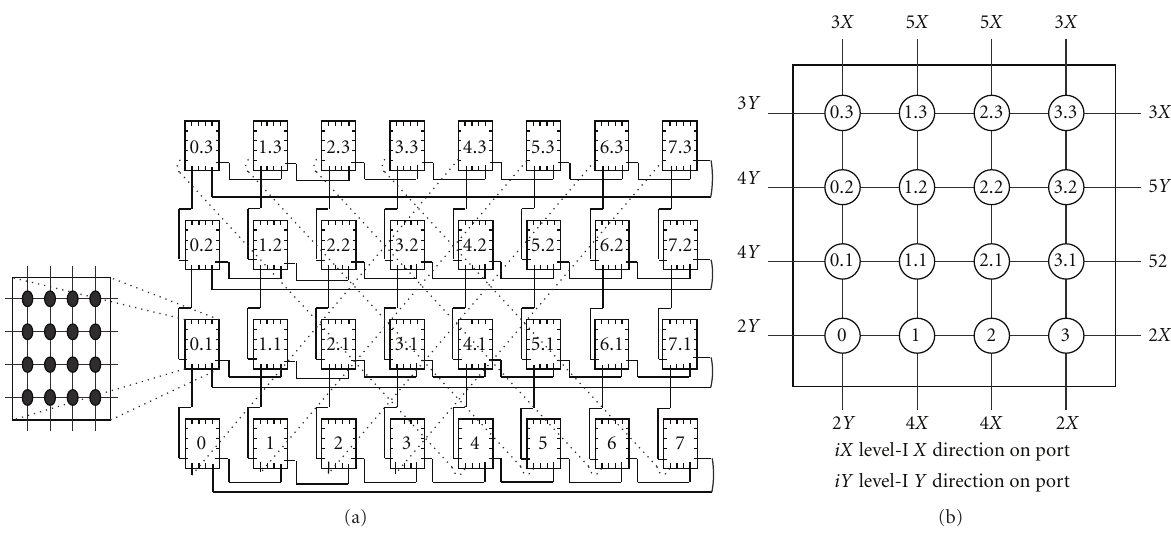
Figure 19: (a) An (2,4,2)-RTTM network and (b) A 4 × 4 Basic Module